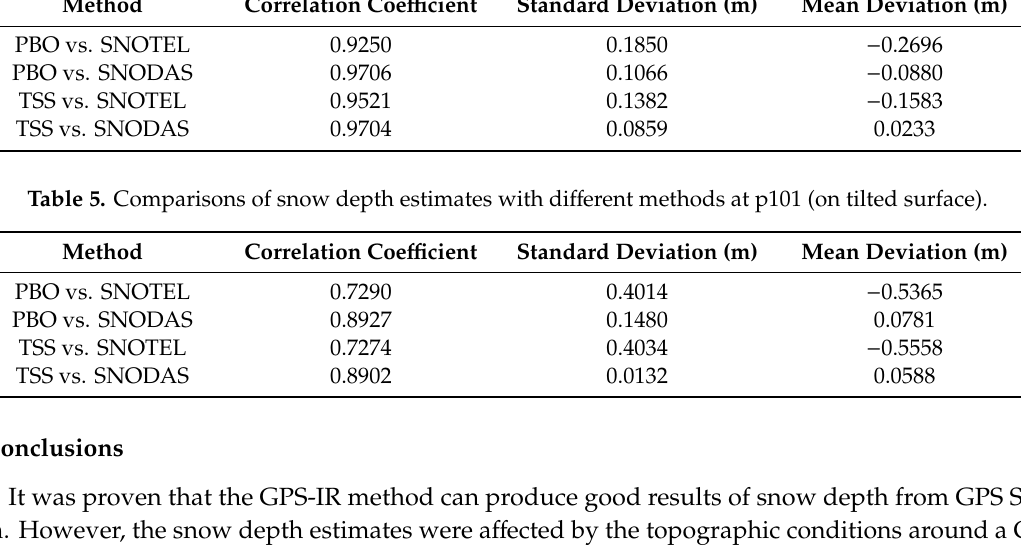
Table 4. Comparisons of snow depth estimates with different methods at p683 (on tilted surface).